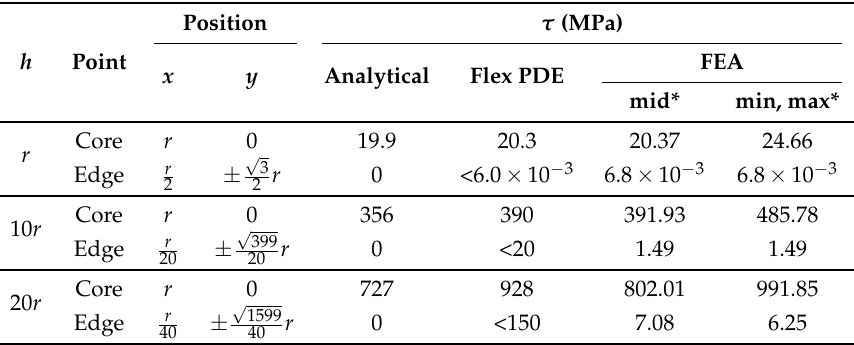
Table 1. Comparison of